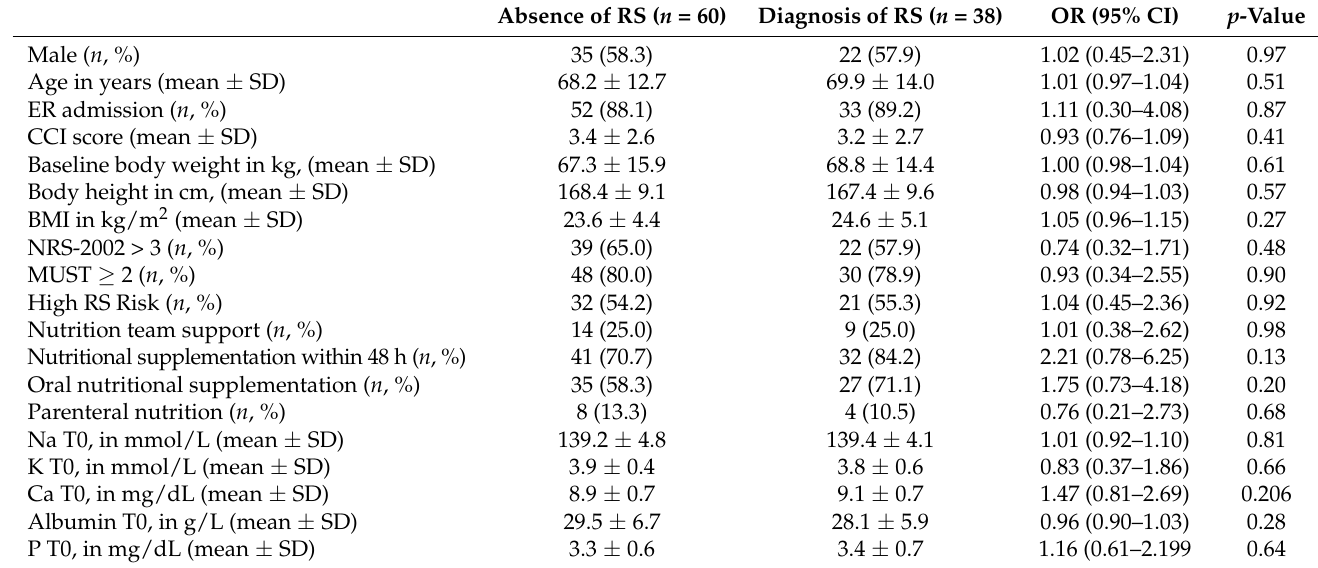
Table 2. Relationships between clinical characteristics and diagnosis of refeeding syndrome (RS) in patients at risk of developing RS ( n = 98).